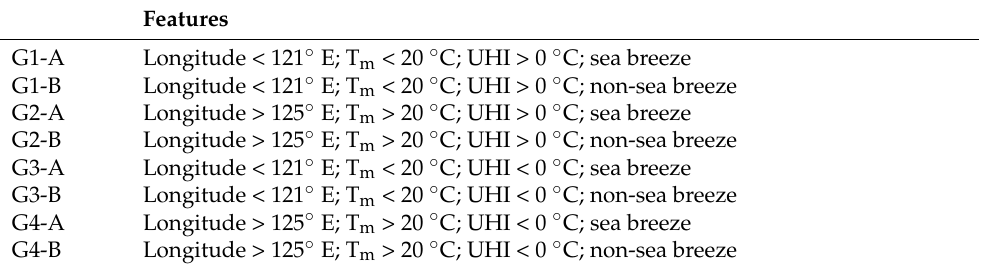
Table 5. Features of groups 1, 2, 3, and 4 and their subgroups when the rainfall amount was lower than 0.1 mm between 11:00 and 19:00 LST during the winter from 2016 to 2019.